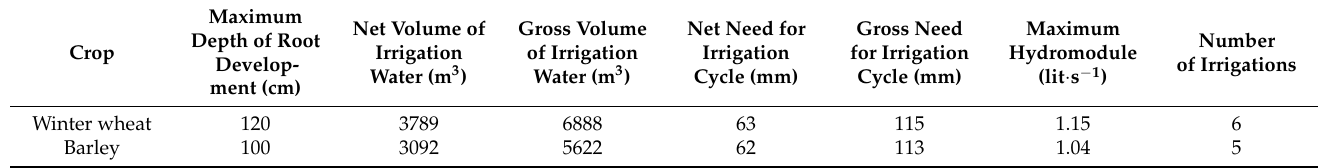
Table 2. Estimation of the water requirements of the planting patterns.